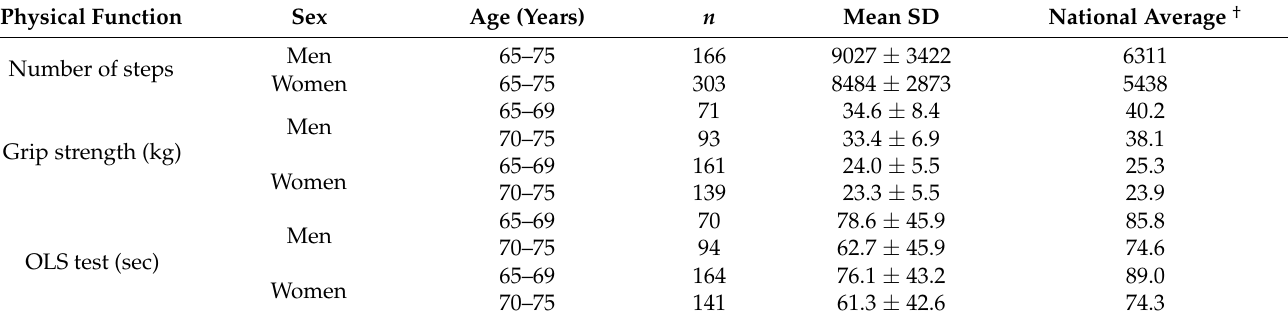
Table 2. Comparison of physical functions between subjects with the national